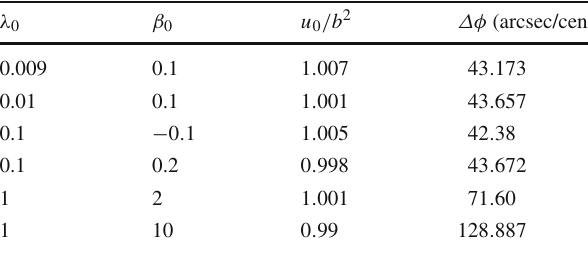
Table 1 Perihilion precession for different parametric values